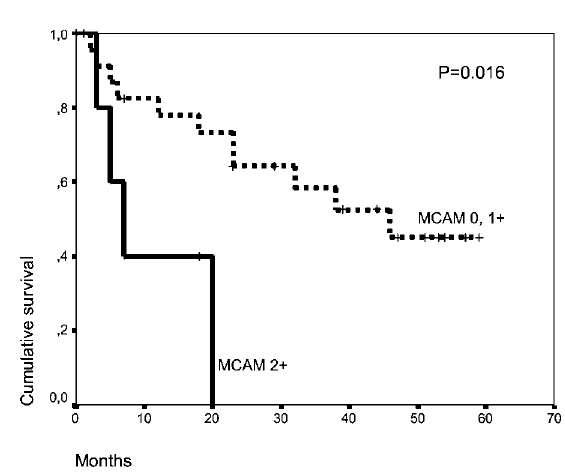
Fig. 2. Survival analysis – Kaplan–Meier curve. Adenocarcinomas only: strong MCAM expression vs. low/no MCAM